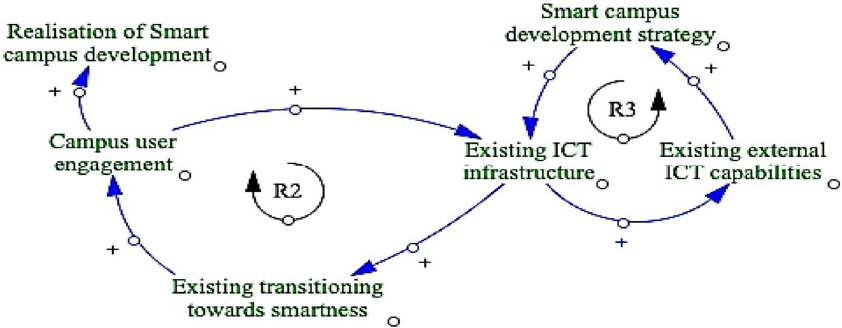
Figure 4. Reinforcing loops R2 and R3.